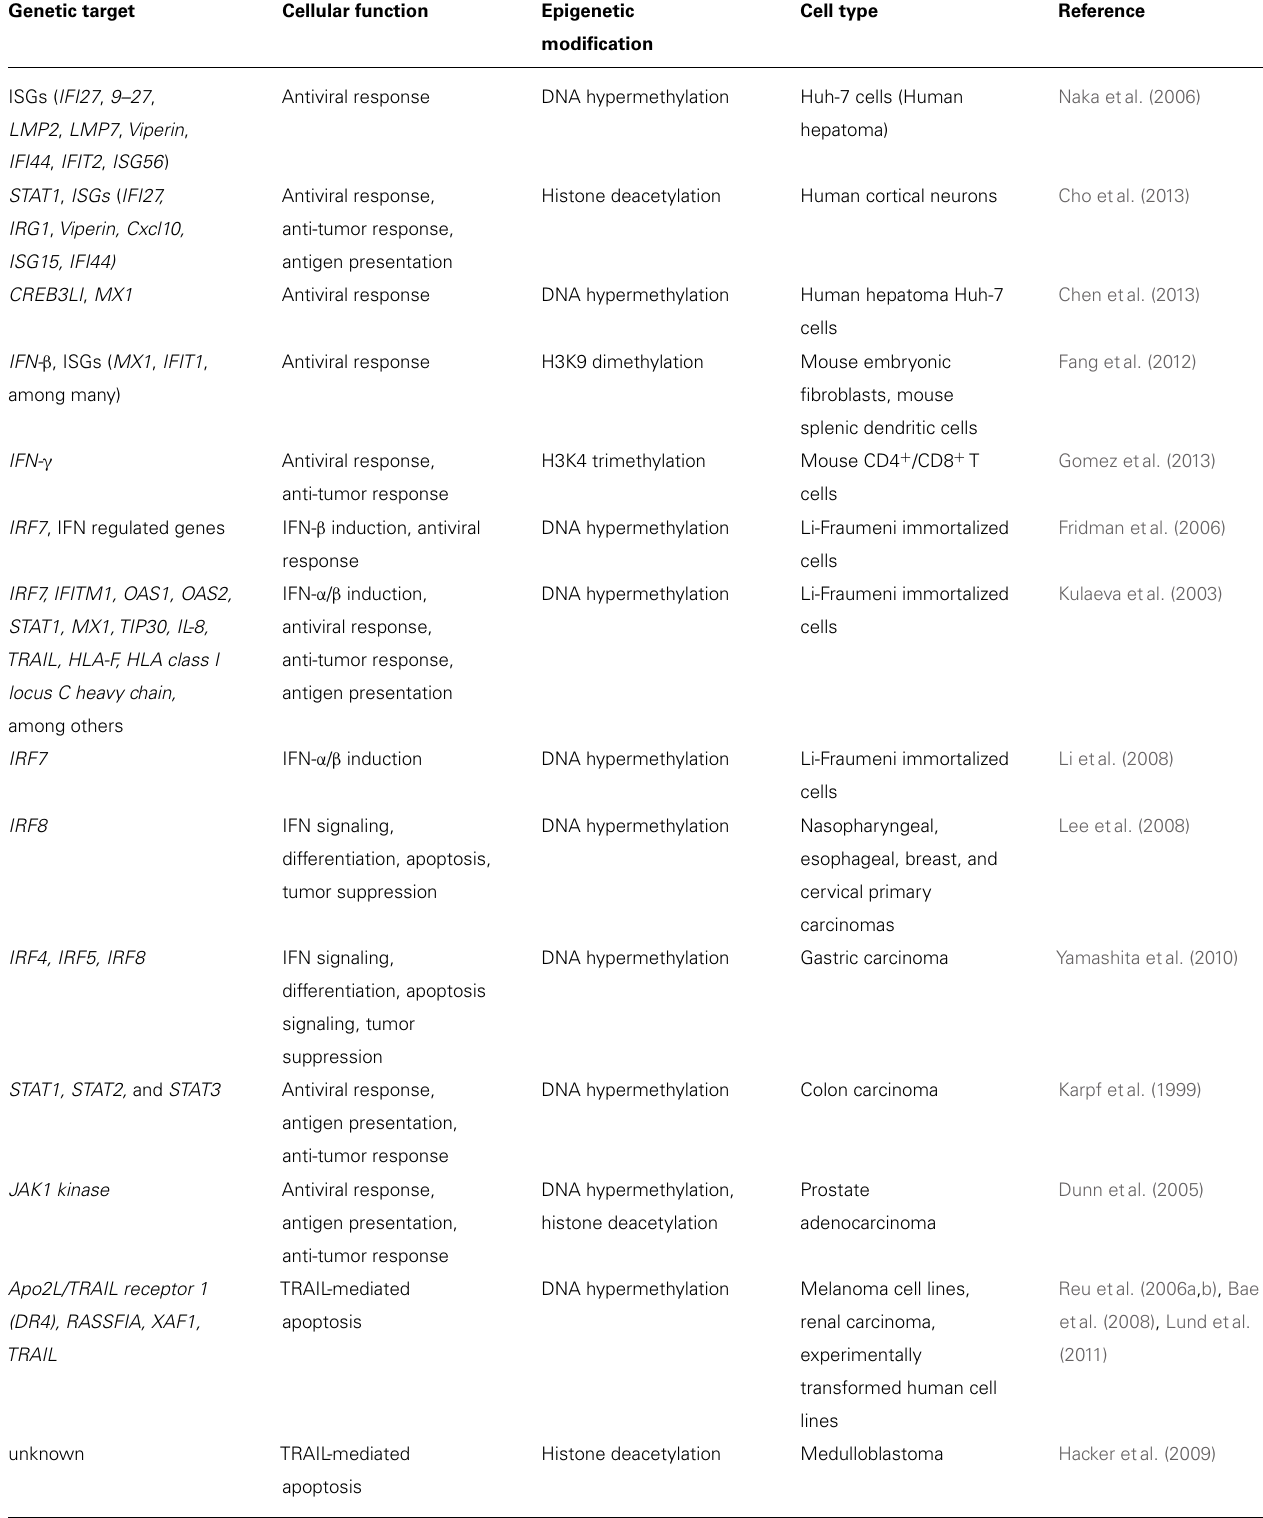
Table 1 | Epigenetic control: implications in cancer and OV